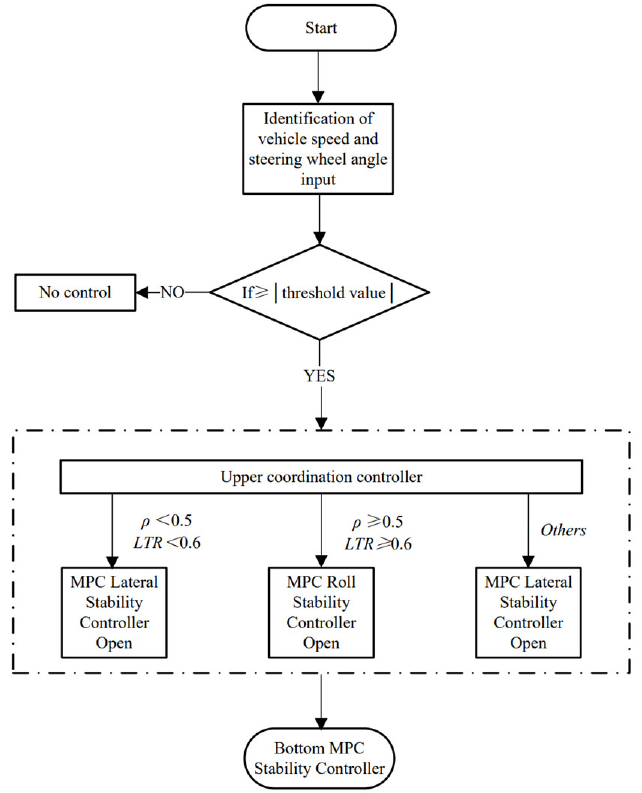
Figure 7. Coordination strategy flowchart.